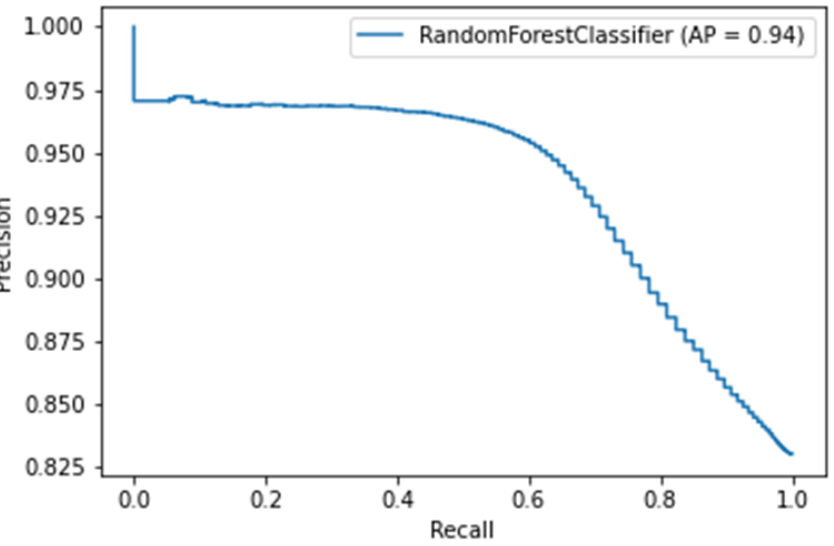
Figure 9. Precision over recall for random forest (corresponds to models in which the feature extraction period is one day, while churn period is also one